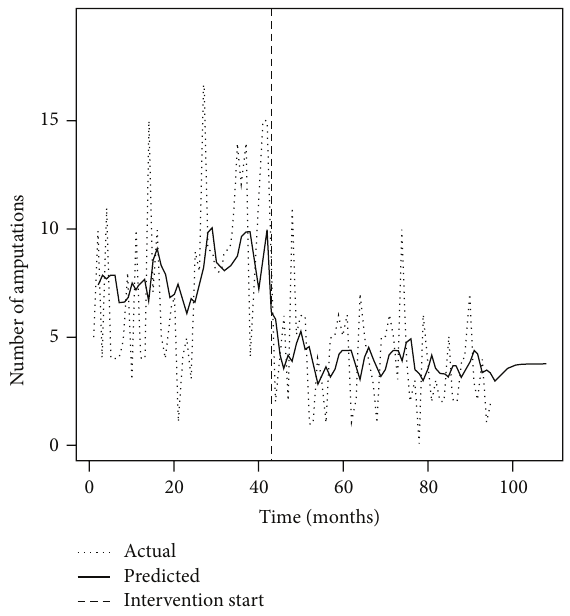
Figure1:Timeseriesanalysisofdiabetes-relatedmajoramputations at Georgetown Public Hospital Corporation